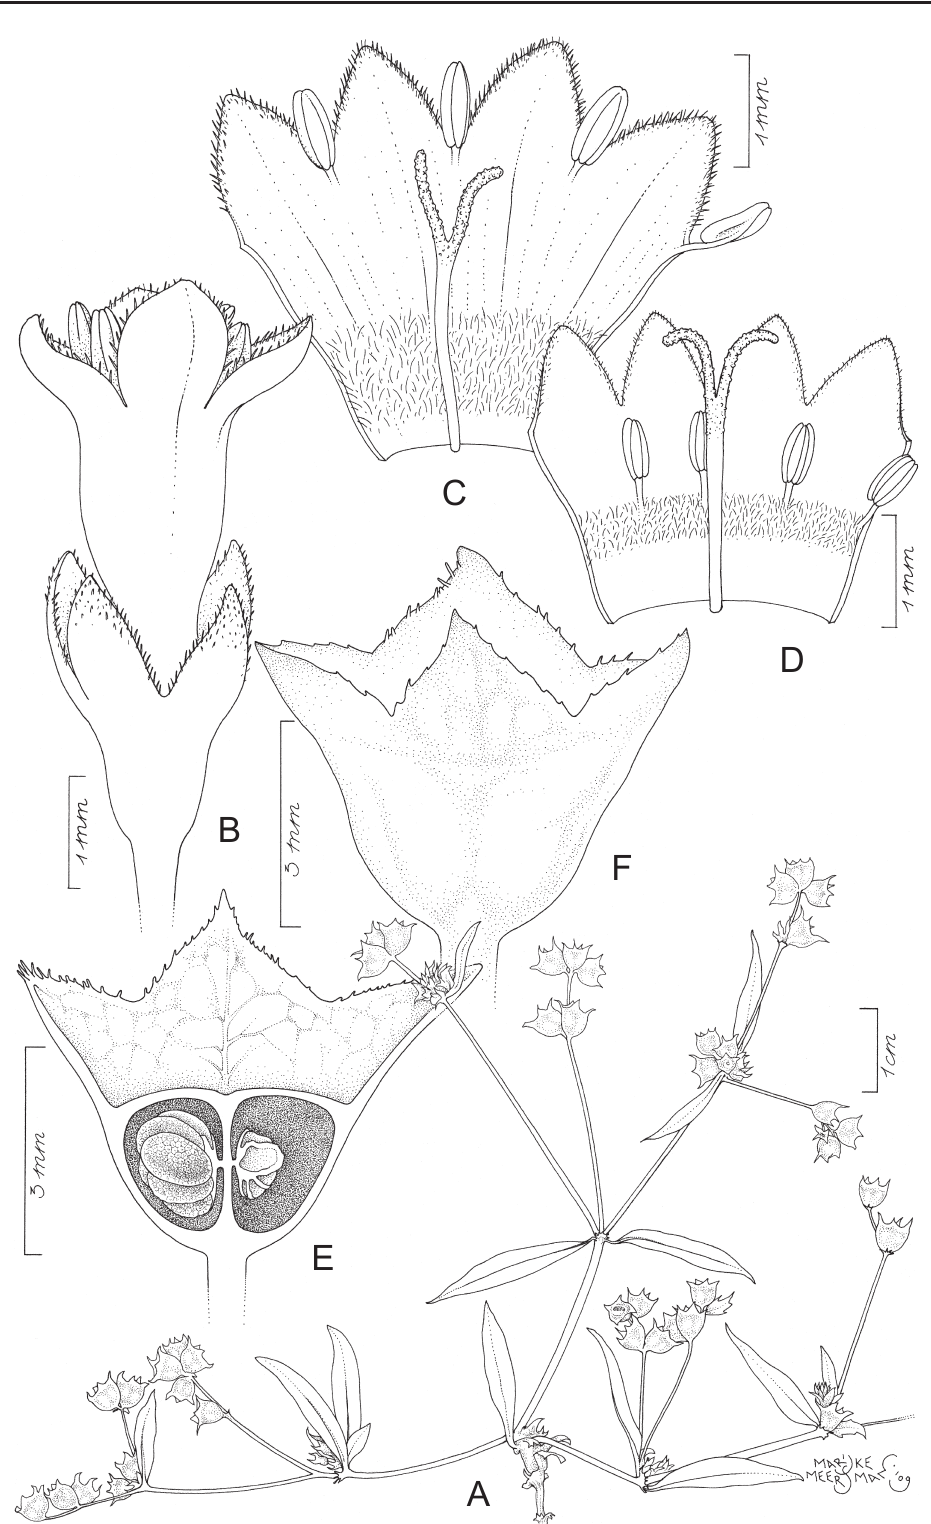
Fig. 15. Astiella pulla Groeninckx sp. nov. A . Habit. B . Brevistylous flower. C . Open brevistylous flower. D . Open longistylous flower. E . Ovary dissected to show placentation; all ovules removed from the right locule to show the placenta. F . Capsule. Drawn by Marijke Meersman. A, E–F from Perrier de la Bâthie 17633 (P); B–D from Groeninckx, De Block & Rakotonasolo 271